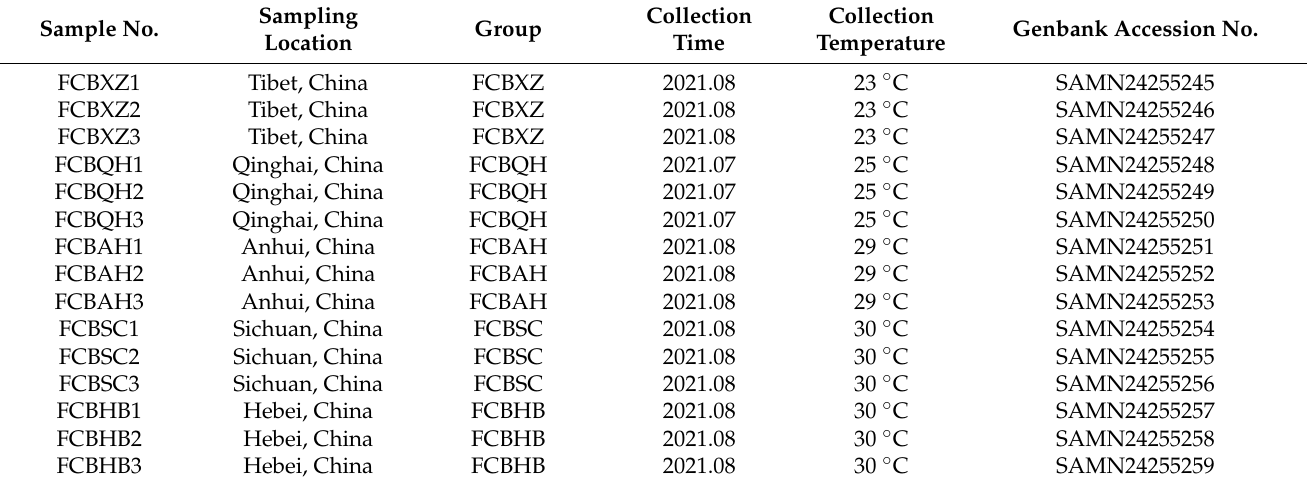
Table 1. Collection information and accession numbers of FCB